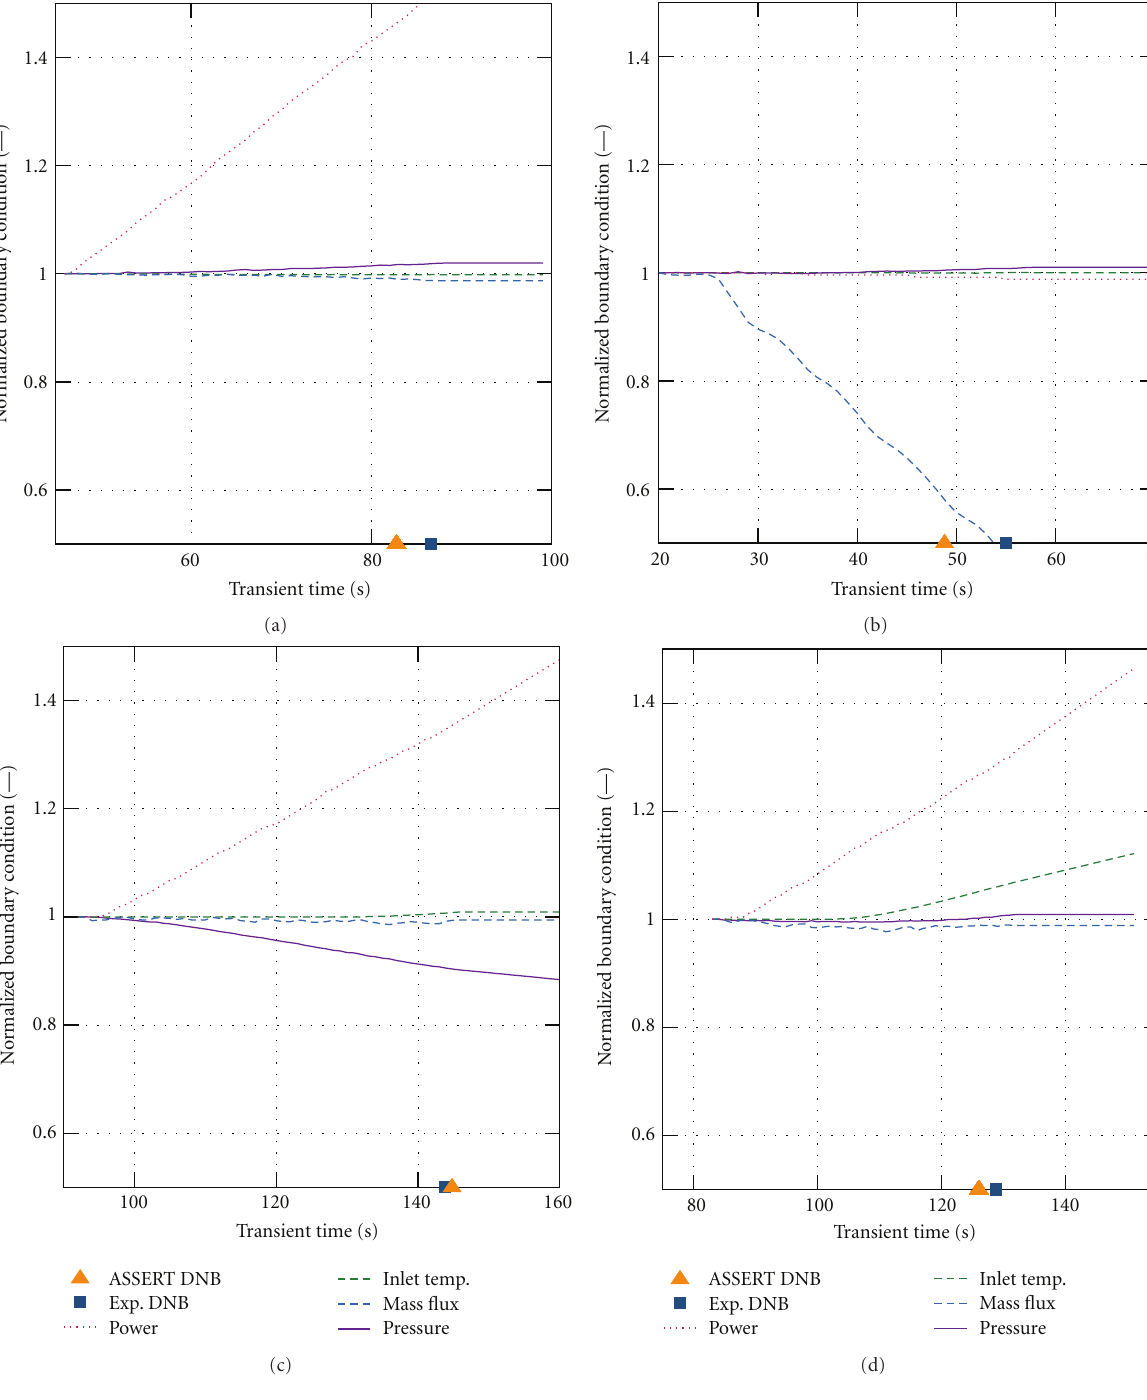
Figure 20: Transient departure from nucleate boiling results for test series A12. Power increase (a), flow reduction (b), depressurization (c), and inlet temperature increase (d). Estimated uncertainty on the power measurements is 2 σ exp =